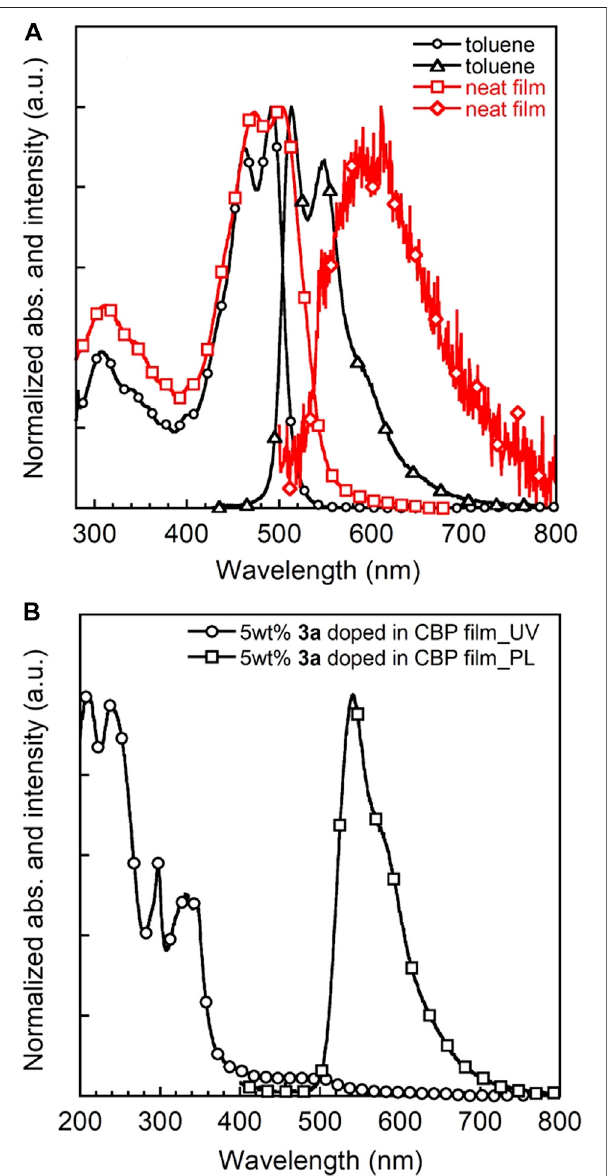
FIGURE 7 | UV-vis and PL spectra of 3a in toluene ( c (cid:1) 1 × 10 − 5 M) and neat fi lm (A) and 5 wt% 3a -doped CBP fi lm (B) .